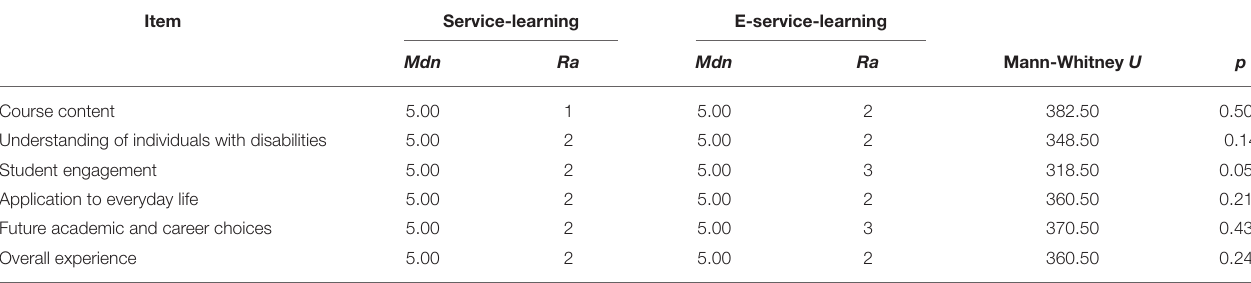
TABLE 1 | Service-learning questionnaire students’ responses.